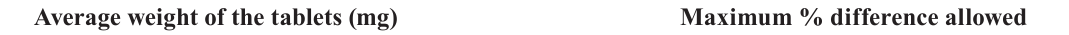
TABLE II - Maximum % deviation allowed for weight variation of tablets